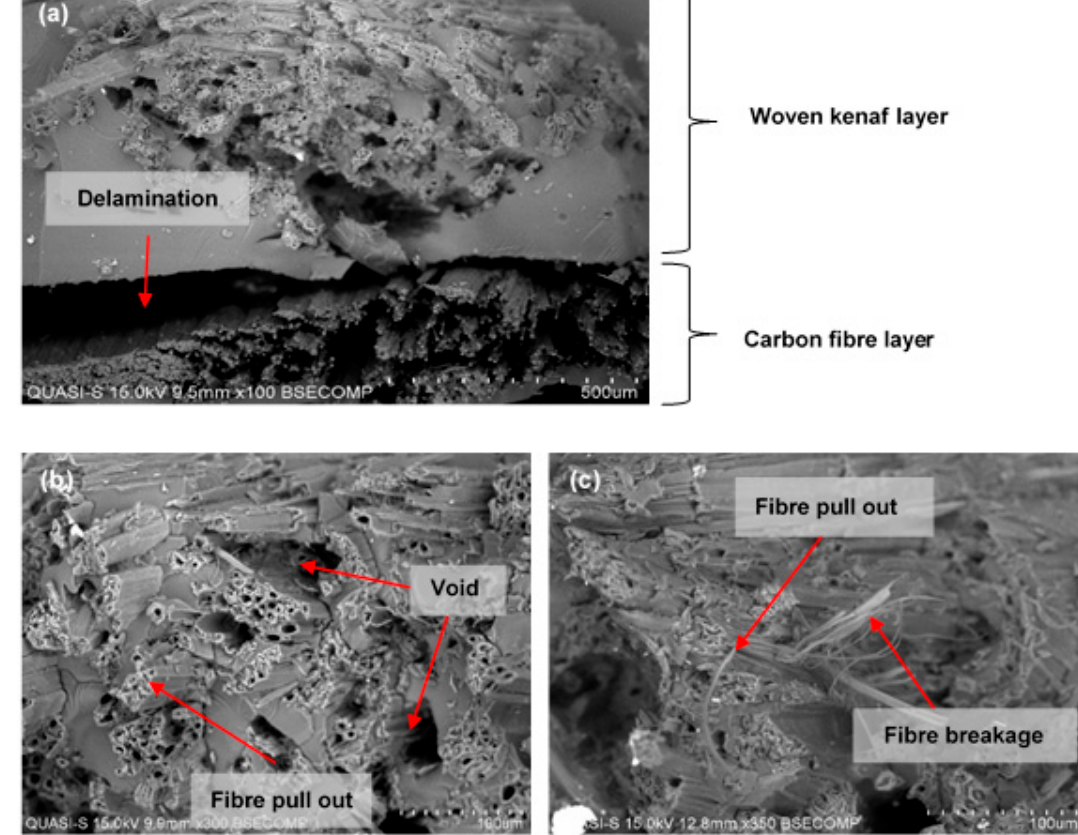
Figure 13. The SEM micrograph of impact fracture surface of laminated satin woven kenaf composite. ( a ) Delamination between layers; ( b and c ) fibre pull out, breakage and voids can be observed at higher magnifications in satin-designed composite.